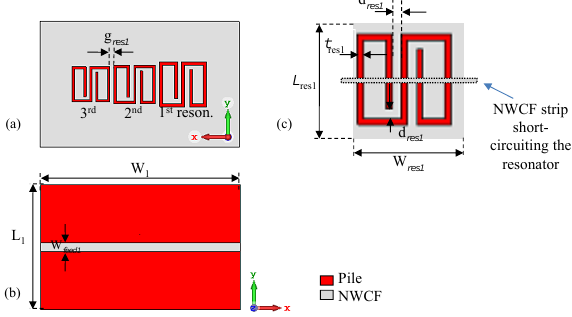
Figure 1. Design of the multi-stopband structure: ( a ) resonators on the back; ( b ) microstrip line on the front; ( c ) zoom of one resonator with details on how the resonance suppression was obtained. c (cid:13) [2019] IEEE. Reprinted, with permission, from